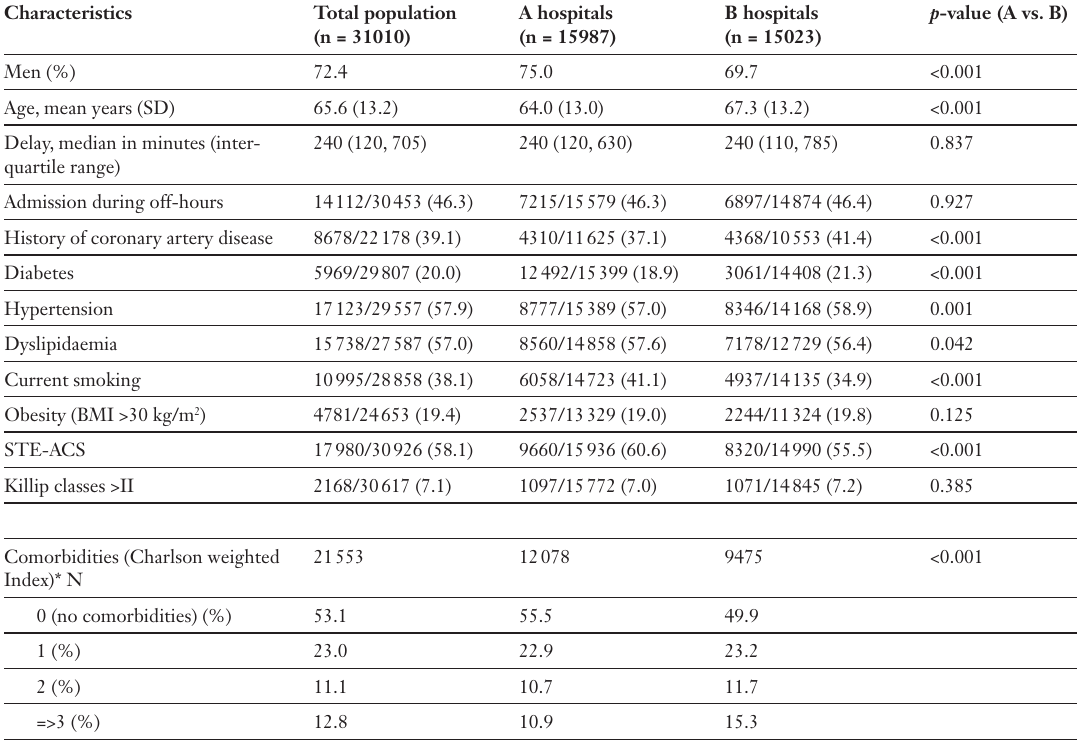
Patients’ baseline characteristics according to the hospital